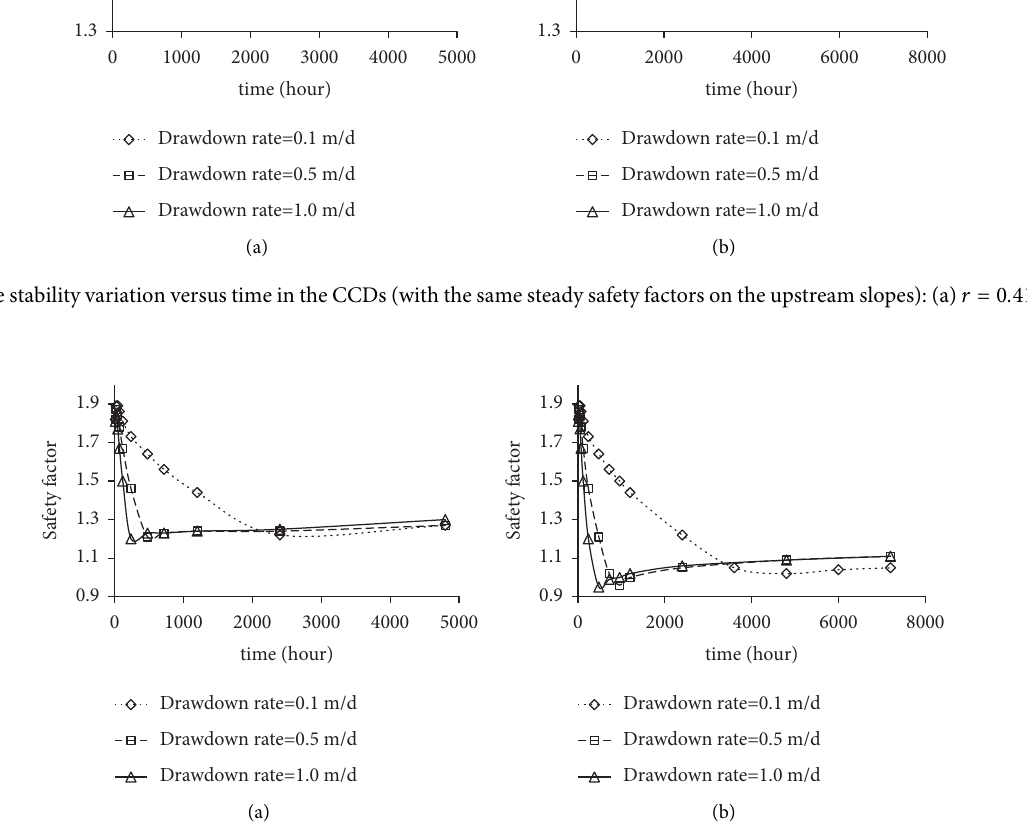
Figure 11: The stability variation versus time in the SUCDs (with the same steady safety factors on the upstream slopes): (a) r � 0 . 415 and (b) r � 0 .